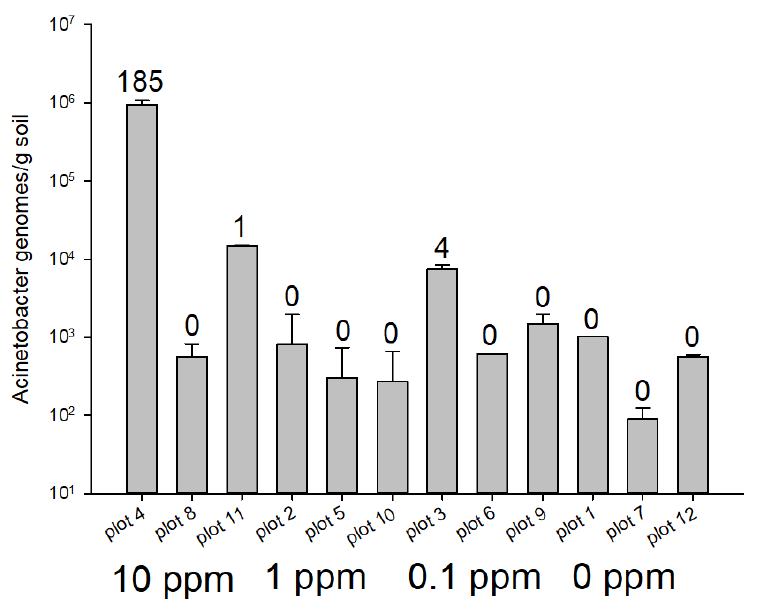
Figure 3. Quantification of an assembled OTU corresponding to Acinetobacter baumanii/A. calcoaceticus in soil samples treated with antibiotics. The number of CaptureSeq reads mapping to this taxonomic cluster in each soil sample is indicated above each